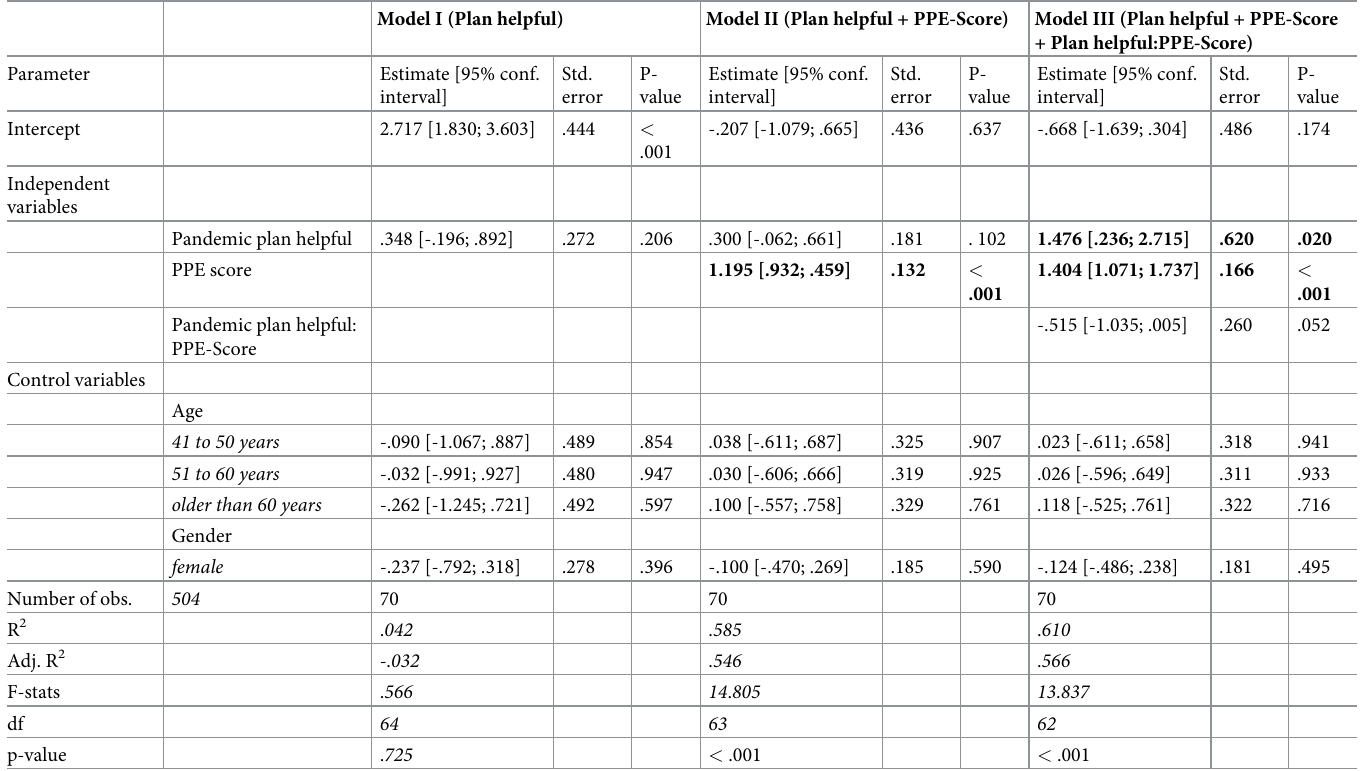
Table 5. Multivariable linear regression model of assessment of pandemic plan as beneficial and pandemic preparedness among general